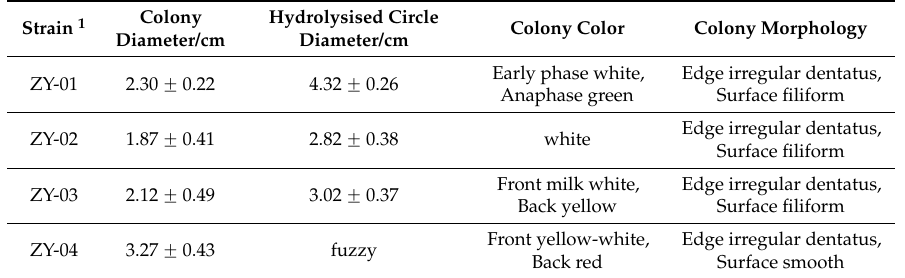
Table 1. Isolated strains for cellulase